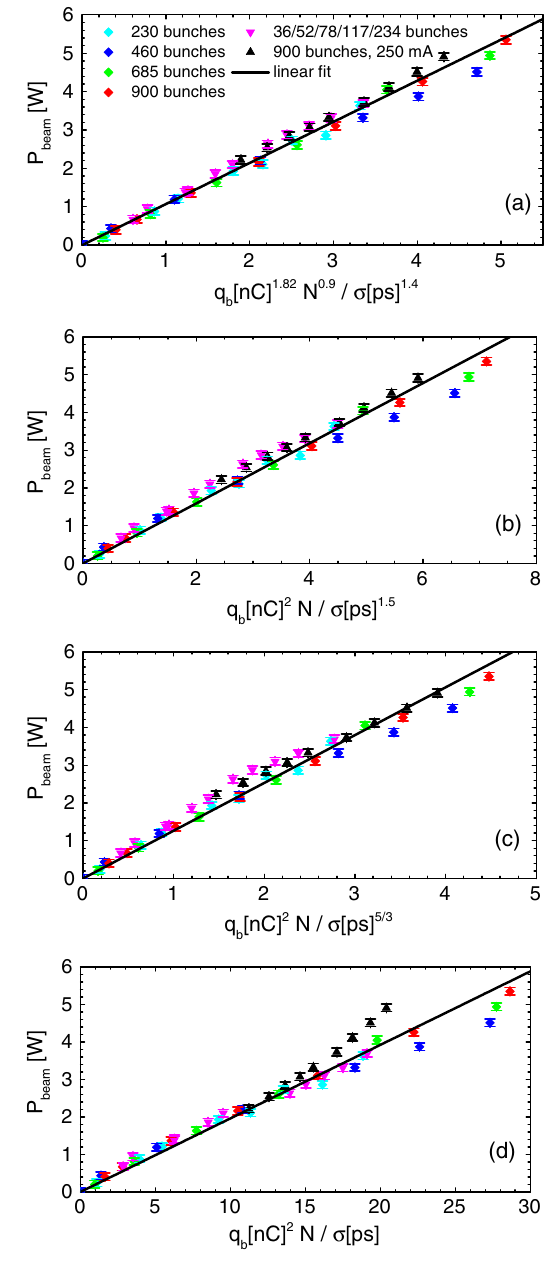
FIG. 4. Comparison of the beam heat load model derived from the measurements and three different rf effect models: (a) empirical with R 2 ¼ 0 . 9854 , (b) resistive wall with normal skin effect with R 2 ¼ 0 . 9746 , (c) with anomalous skin effect with R 2 ¼ 0 . 9712 , (d) step transition with R 2 ¼ 0 . 9602